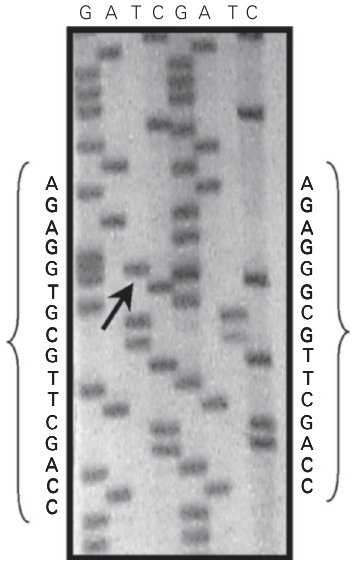
Figure 1. Sequencing analysis by conformation-sensitive gel electrophoresis of the mutation that caused the differential mi- gration pattern. The four lanes on the left correspond to the normal promoter gene se- quence. The four lanes on the right are from the blood donor’s sample where the shift was de- tected. The arrow indicates the presence of the T base in the normal